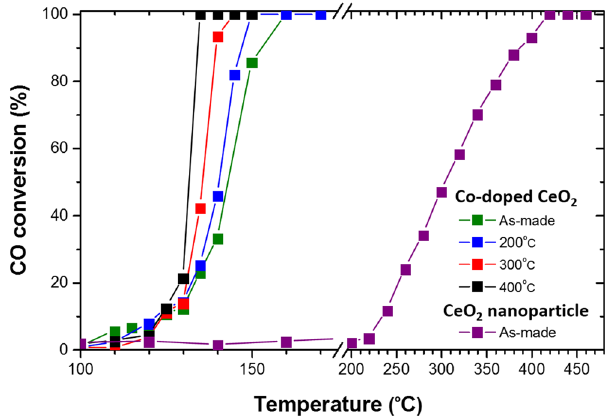
Figure 7. Catalytic activity of CO oxidation for CeO 2 and Co-doped CeO 2 nanoparticles annealed at different